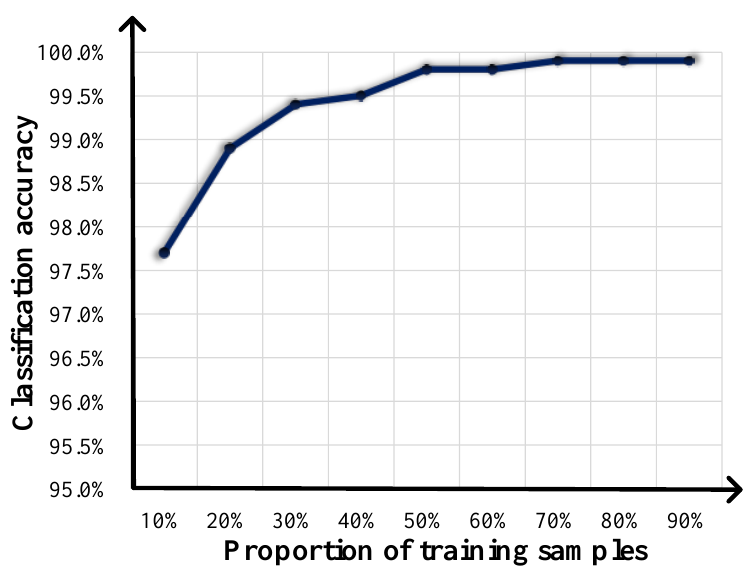
Figure 7. Classification performance with different proportions of training samples for activ- ity